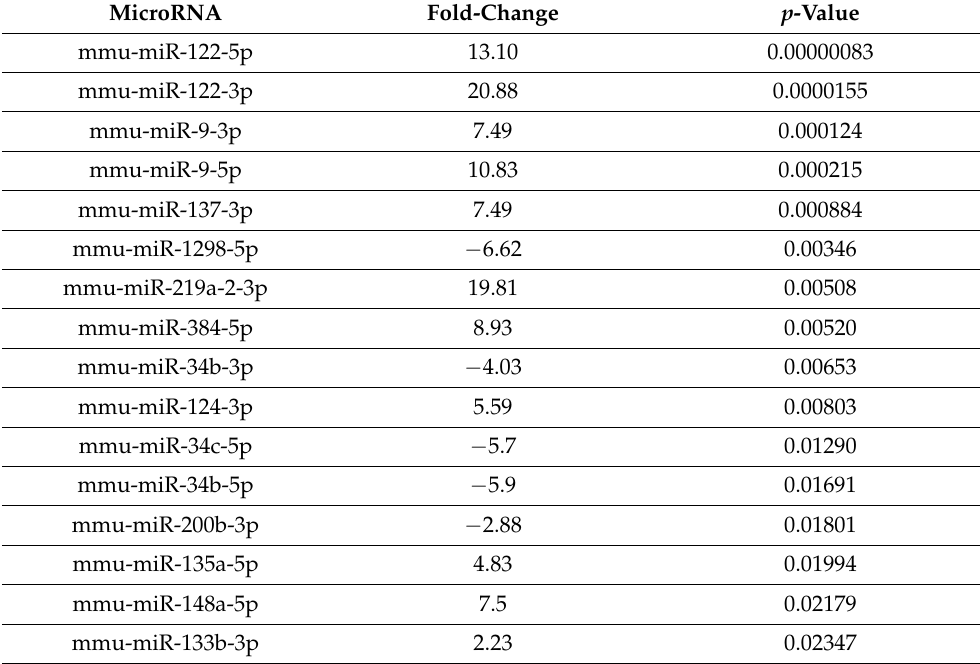
Figure 1. Schematic representation of the overall experimental design. Sham or ICH was induced in aged, male mice. Blood was collected at 24 h post-sham/ICH and serum miRNAs were extracted and subjected to microRNA sequencing. Table 1. Serum microRNAs that exhibited differential expression between sham and ICH ( p <